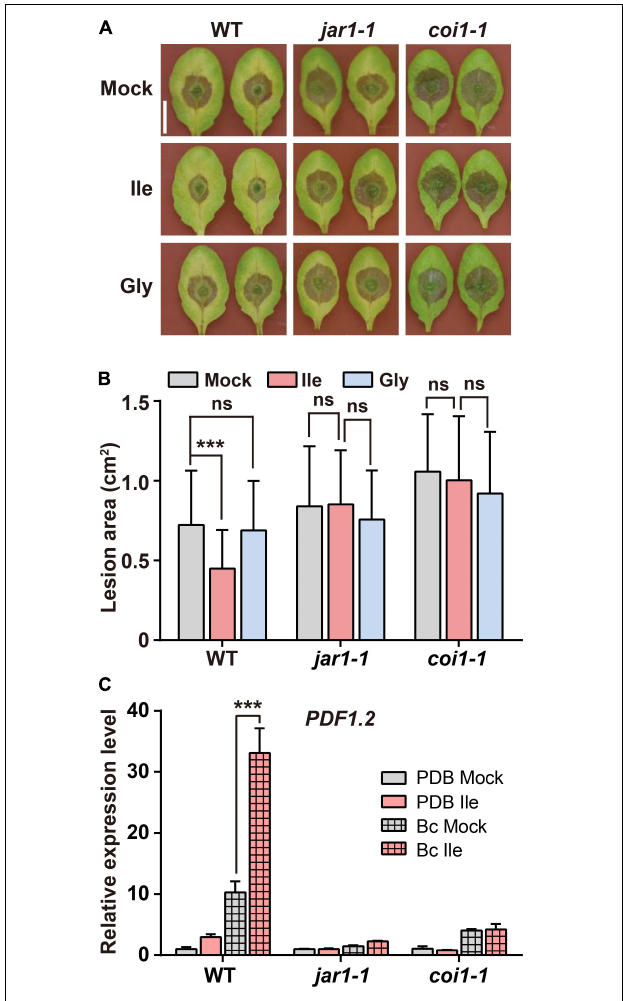
FIGURE 3 | Ile enhances plant resistance to B. cinerea depending on JAR1 and COI1. (A,B) Representative phenotype (A) and lesion area (B) of WT, jar1-1 , and coi1-1 leaves after B. cinerea infection for 3 days. Five-week-old plants were pretreated with 0.05% Tween 20 solution (Mock), 10 mM Ile, or 10 mM Gly for 2 days before B. cinerea inoculation. Scale: 1 cm. Data are means ± SD ( n = 32–51 leaves). (C) Transcript level of defensive gene PDF1.2 in the leaves of WT, jar1-1 , and coi1-1 plants. Four-week-old plants were pretreated with 0.05% Tween 20 solution (Mock) or 10 mM Ile for 2 days. The 7th–9th rosette leaves were detached and inoculated with PDB or B. cinerea spores suspension (Bc) for 48 h, and then collected for quantification of PDF1.2 transcript level. Data are means ± SD ( n = 3 samples, each sample contains three leaves). ACTIN8 is used as the internal control. Statistical significances were calculated via Student’s t -test (*** p < 0.001, “ns” p >